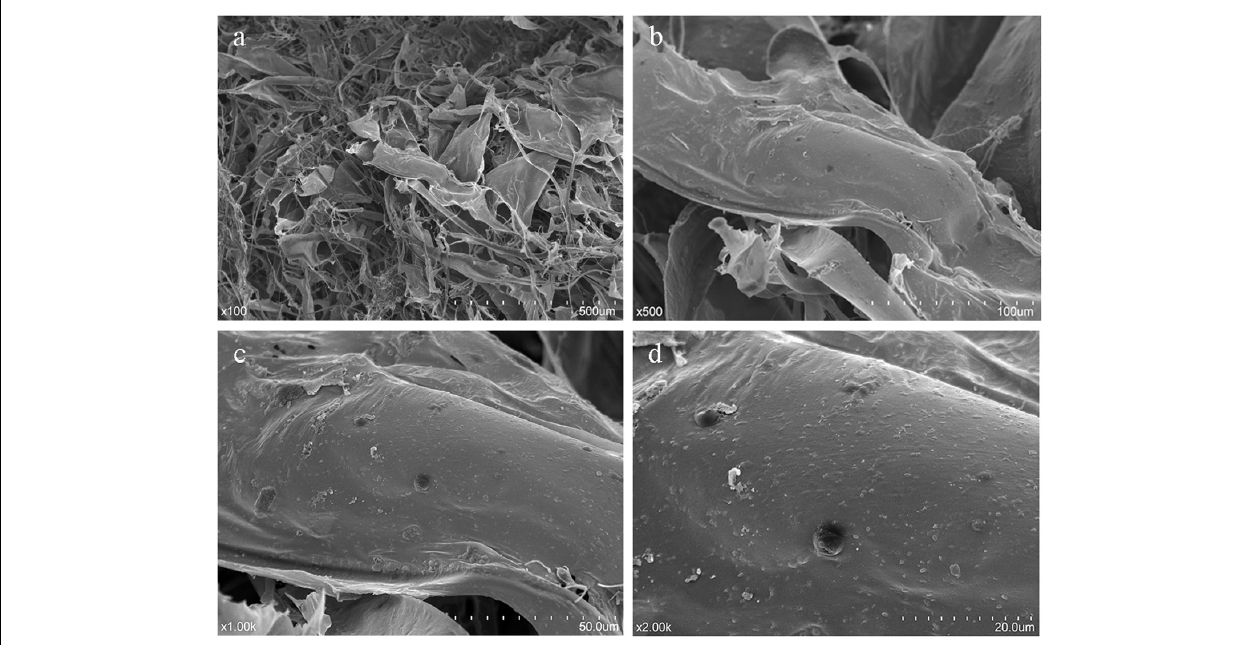
FIGURE 7 | Antidiabetic effect of Heimioporus retisporus Polysaccharide (HRP). (A) Fasting blood glucose (FBG) level. (B) Weight. (C) Visceral organ index of heart. (D) RT-PCR of TNF- α and IL-6. Values are expressed as mean ± SE. * p < 0.05 for comparison with CK group.